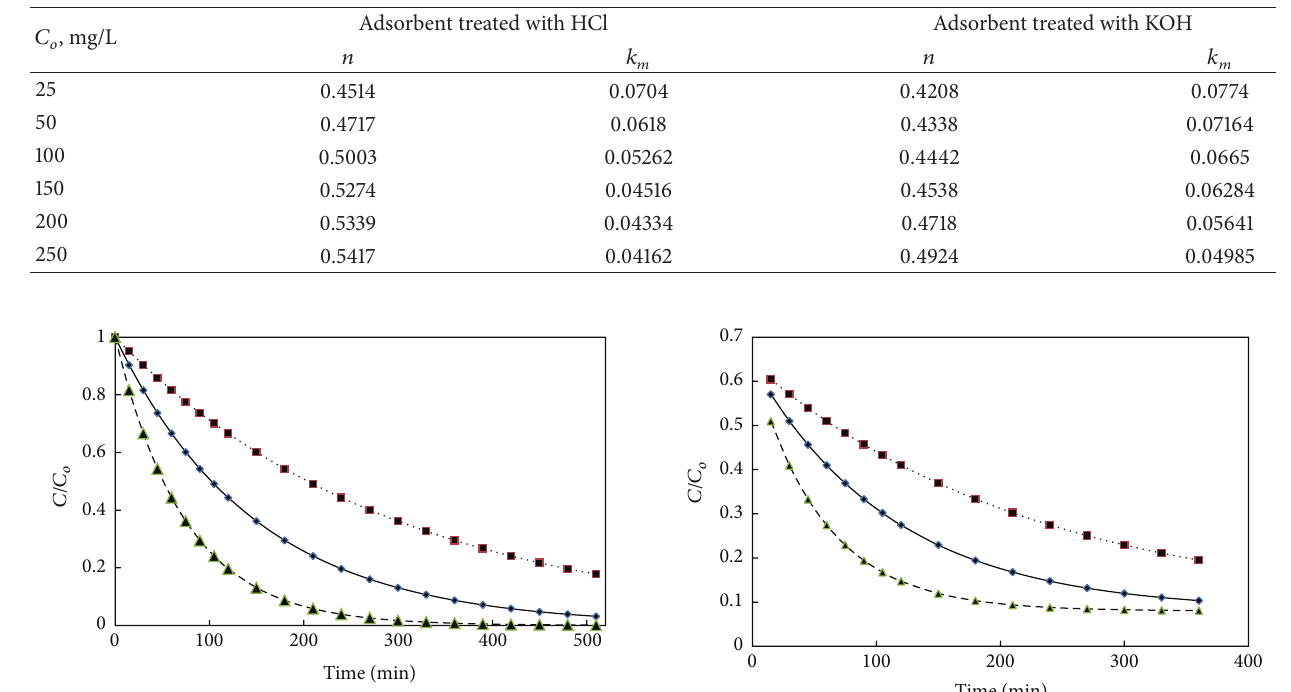
Table 10: The transport number and the model constant for both adsorbents at different initial concentrations.